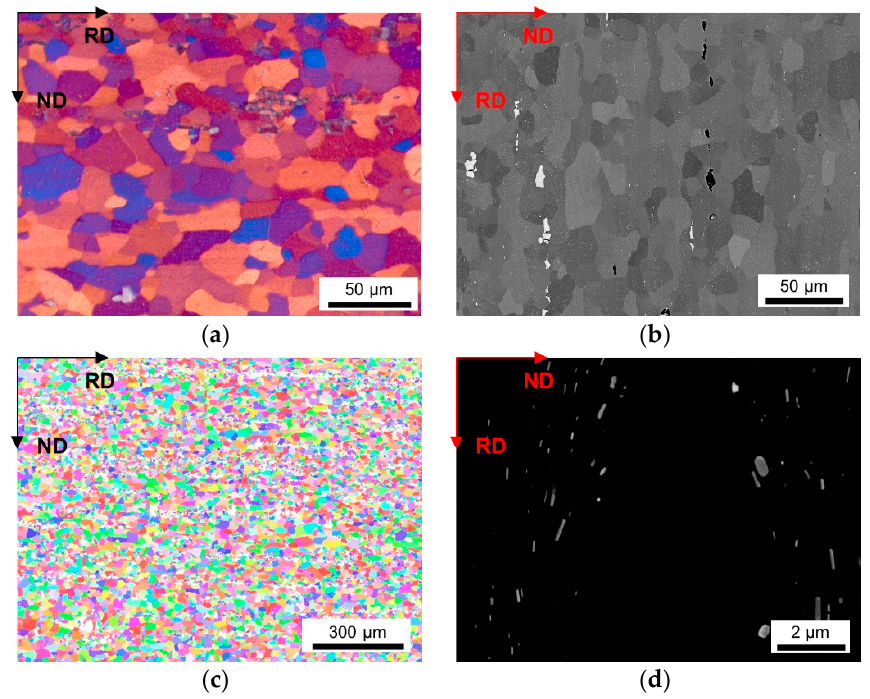
Figure A25. Microstructure of the soft annealed HFe-HMn cast under S-C conditions, homogenized at 550 °C and cold rolled to a CRD of 35%. ( a ) LOM. ( b ) BSE image. ( c ) EBSD IPF map in RD–ND plane. ( d ) BSE micrograph showing dispersoids.